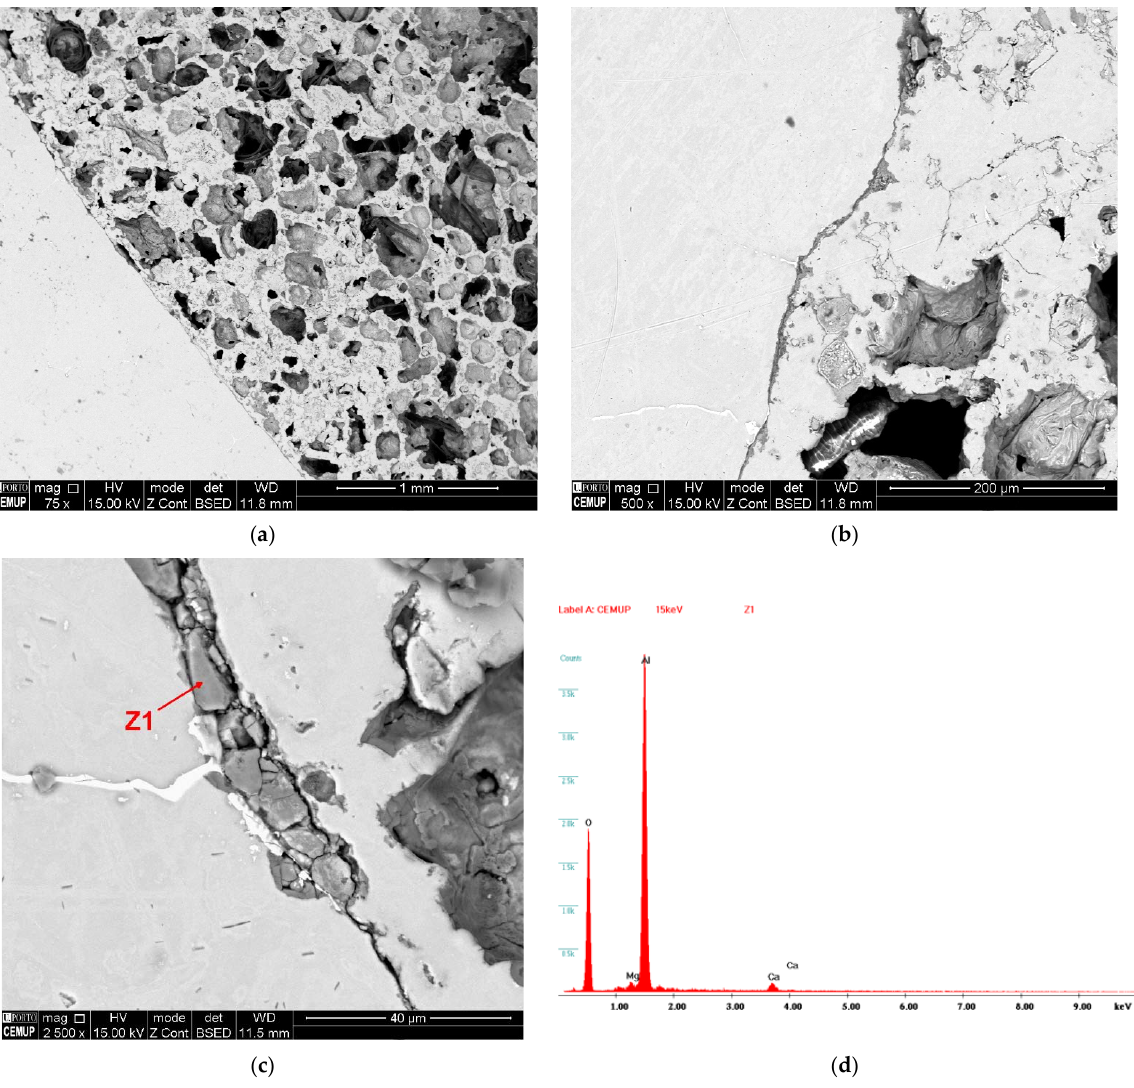
Figure 5. Scanning electron microscopy detail of Al-EAn post-homogenization: ( a ) porosity of EAn; ( b ) dark coating on EAn surface; ( c ) thickness of the oxide coating; ( d ) EDS analysis on the AlMg0.7Si–EAn interface.